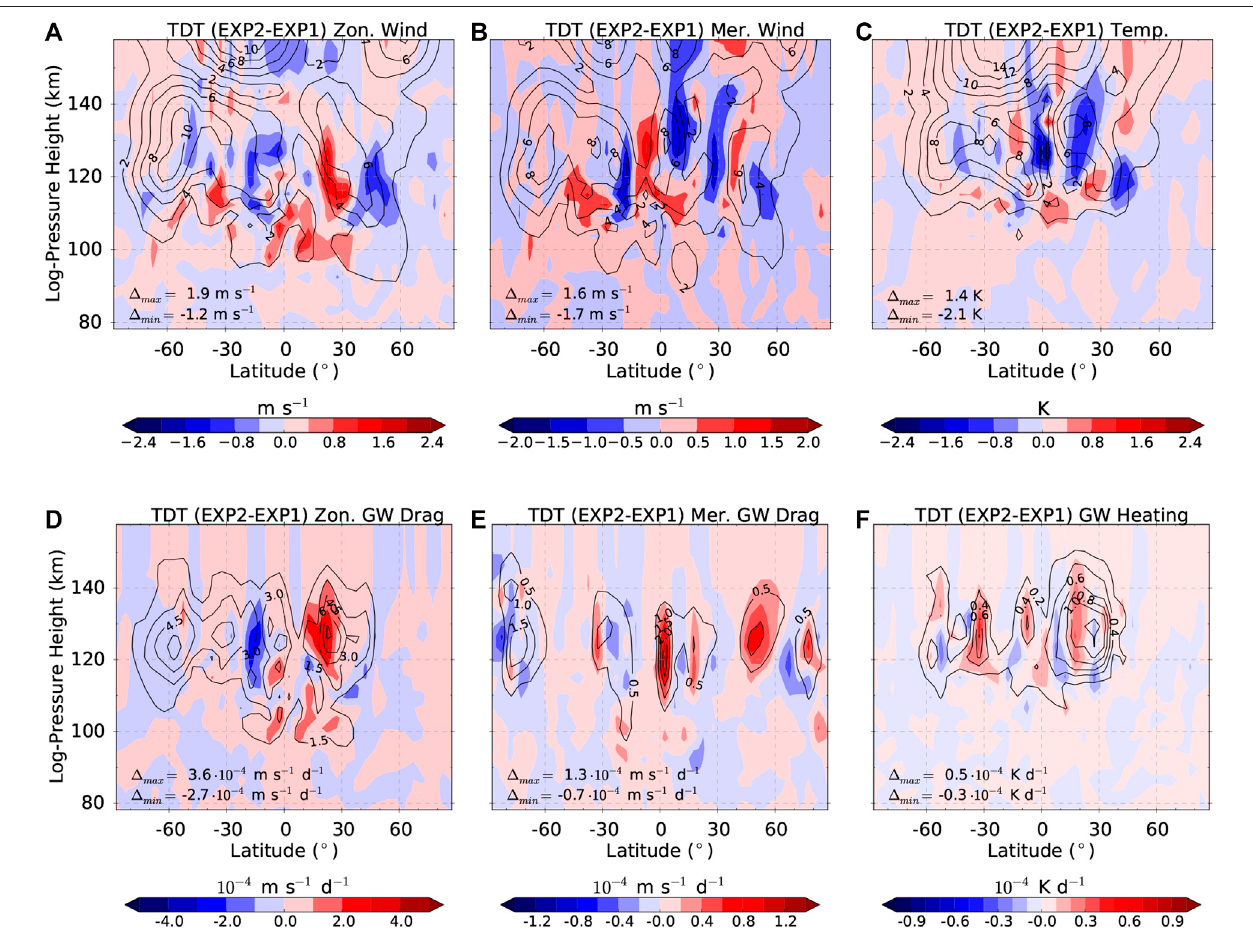
FIGURE 10 | Zonal mean TDT amplitudes of EXP2 for (A) zonal wind, (B) meridional wind, (C) temperature, (D) zonal GW drag, (E) meridional GW drag and (F) heating due to GWs (black contour lines). Intervals are (A,B) 2 m s − 1 , (C) 2 K, (D) 1 . 5 · 10 − 4 m s − 1 d − 1 , (E) 0 . 5 · 10 − 4 m s − 1 d − 1 , and (F) 0 . 2 · 10 − 4 K d − 1 . Positive/ negative differences EXP2-EXP1 ( Δ ) are shaded in red/blue. Their maximum/minimum values ( Δ max / Δ min ) are given in each panel.